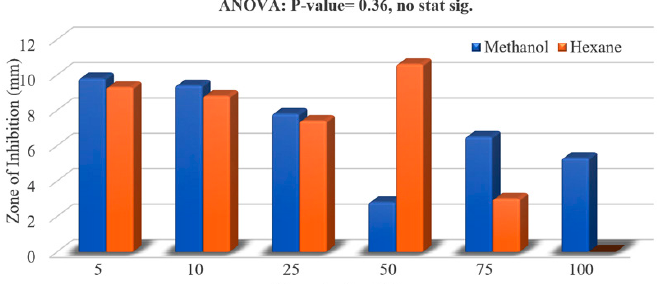
Fig. 5. Difference in zone of inhibition at different conc. for methanol and hexane extract of C.